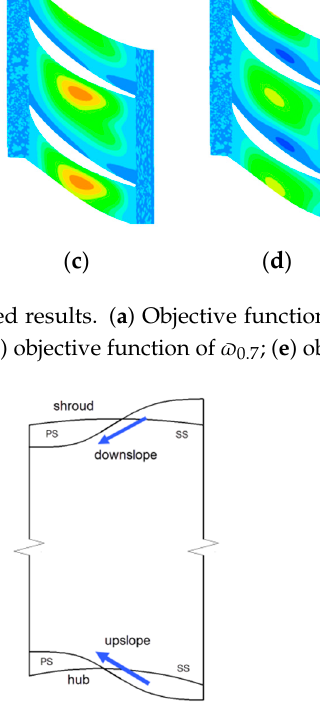
Table 3. Names of optimization schemes for each objective function and the baseline values (CFD).